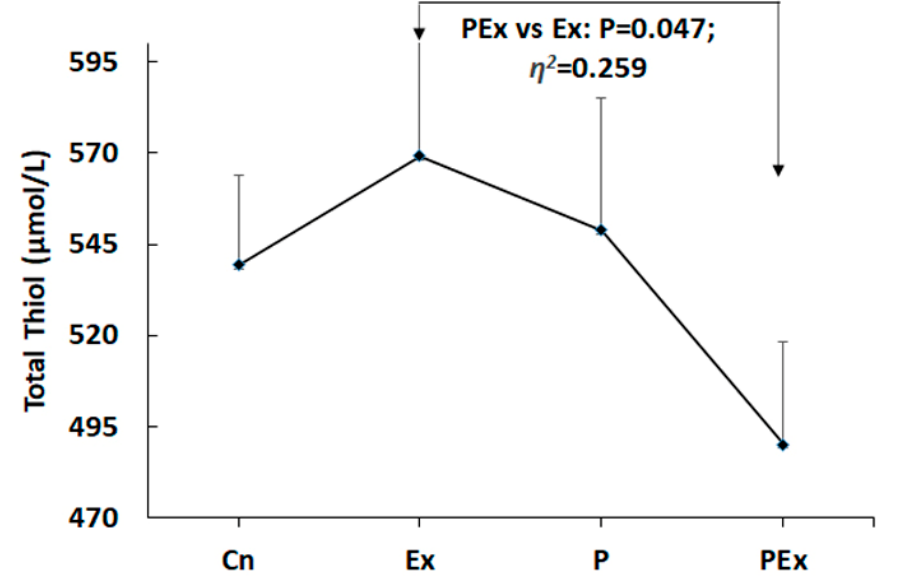
Figure 2. Total thiol levels. The total thiol level was found to be significantly higher in the EX group as compared with in the PEx group. The use of probiotics alone did not have any effect on the total thiol level.